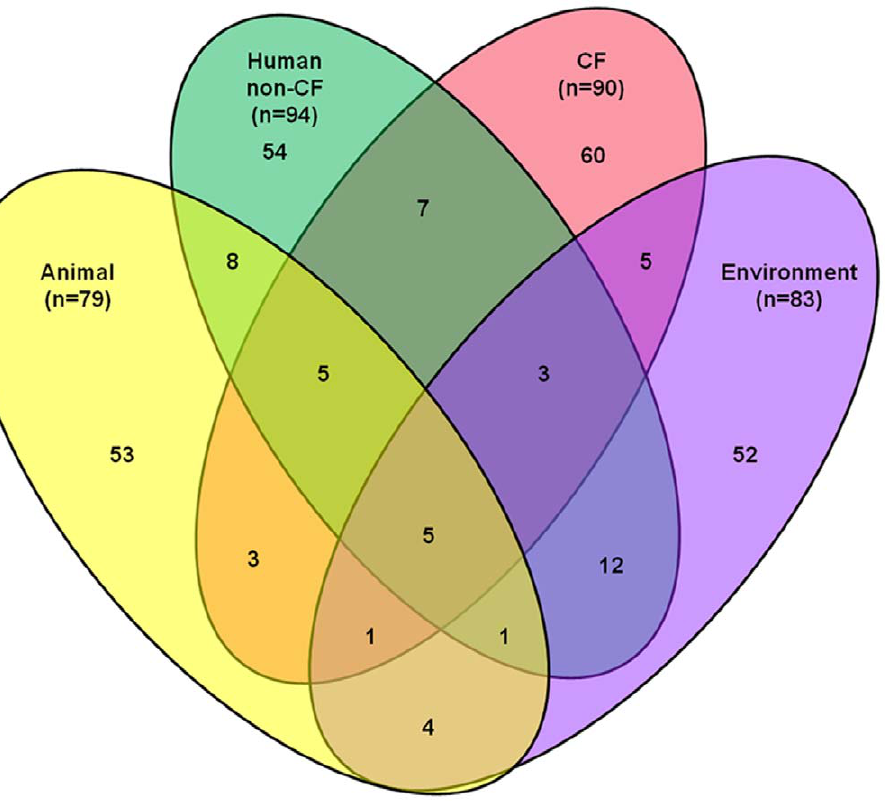
Figure 3. Venn diagram showing the number of individual sequence types (STs) detected in each of the ecological niches. C: STs detected in cystic fibrosis patients; Human non-CF: STs detected in non-cystic fibrosis patients; Animal: STs detected in animals; Environment: STs detected in environmental samples. doi:10.1371/journal.pone.0044199.g003 PLOS ONE |